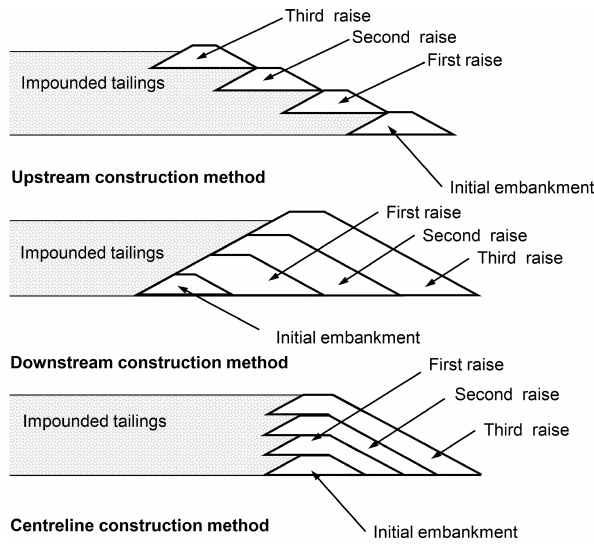
Figure 1. Different methods of construction for tailings dams (source: adapted from Vick,